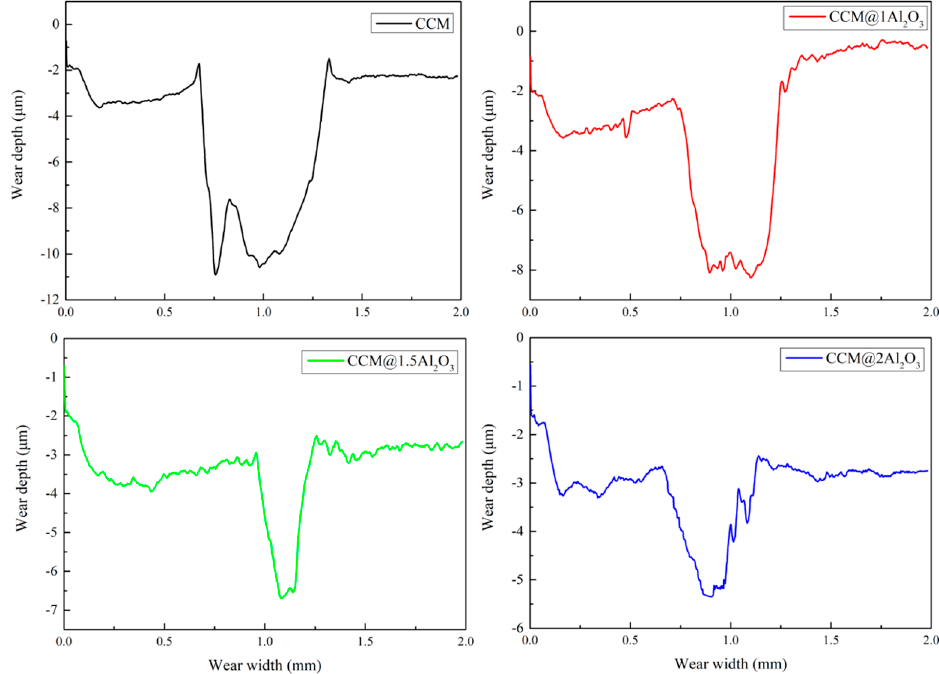
Figure 10. The wear tracks of the LPBF-processed Figure 10 . The wear tracks of the LPBF-processed parts.